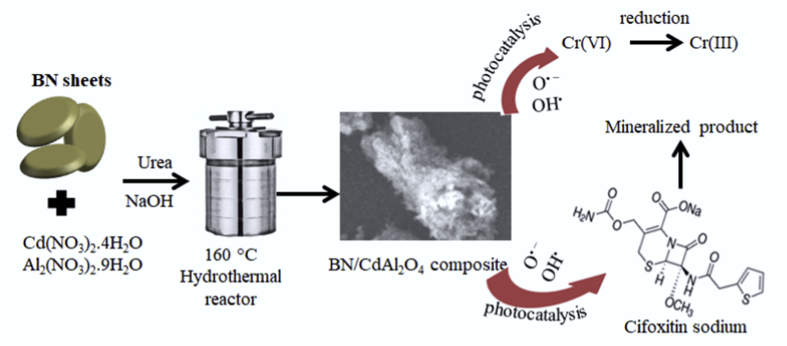
Schematic diagram for the synthesis of BN-0.2/CdAl2O4 composite and its photocatalytic application.